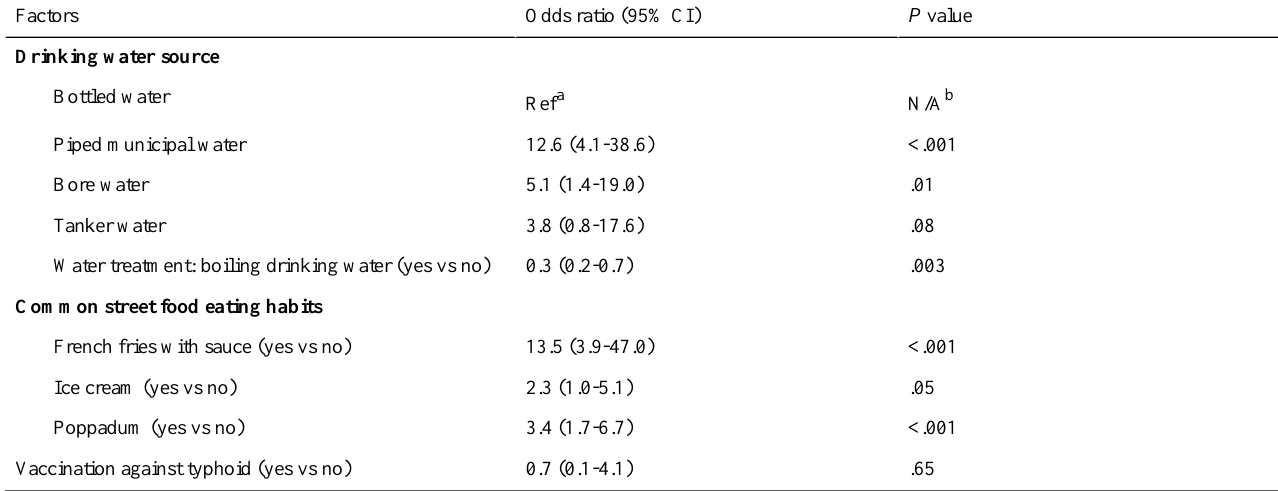
Table 2. Univariate analysis of risk factors among 75 cases of extensively drug resistant typhoid fever and 75 age- and sex-matched controls enrolled in this study in Karachi, Pakistan, in